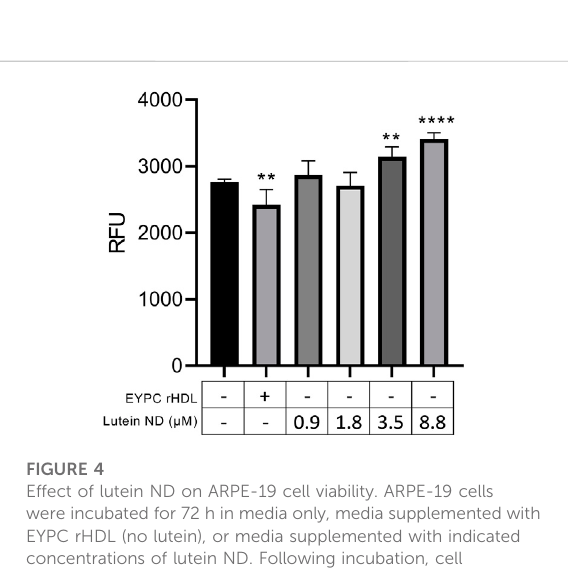
FIGURE 4 Effect of lutein ND on ARPE-19 cell viability. ARPE-19 cells were incubated for 72 h in media only, media supplemented with EYPC rHDL (no lutein), or media supplemented with indicated concentrations of lutein ND. Following incubation, cell viability assays were performed. Sample fl uorescence emission was measured at 590 nm (excitation 530 nm). Values reported are the mean ± standard error ( n = 6); pp = p < 0.01, pppp = p < 0.0001 vs.